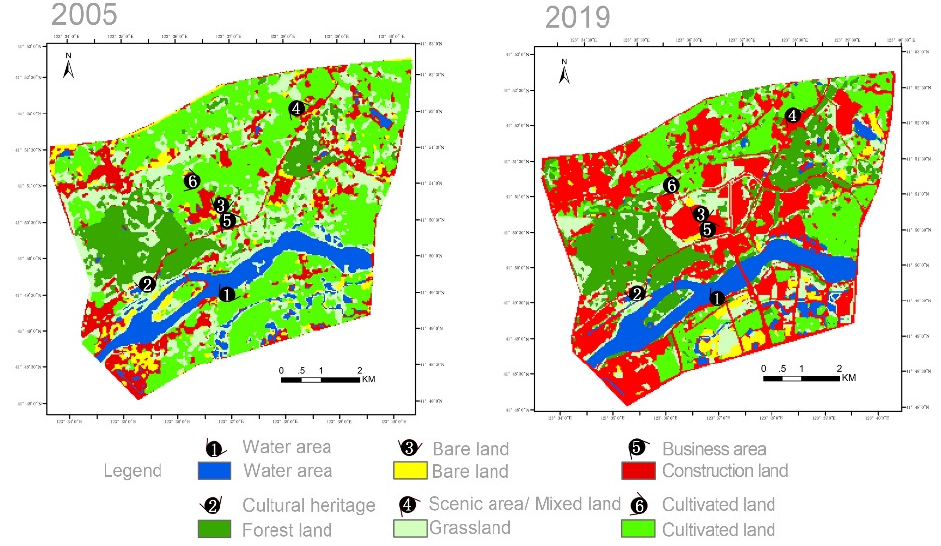
Figure 2. Locations of photos taken and land use analysis in 2005 and 2019.